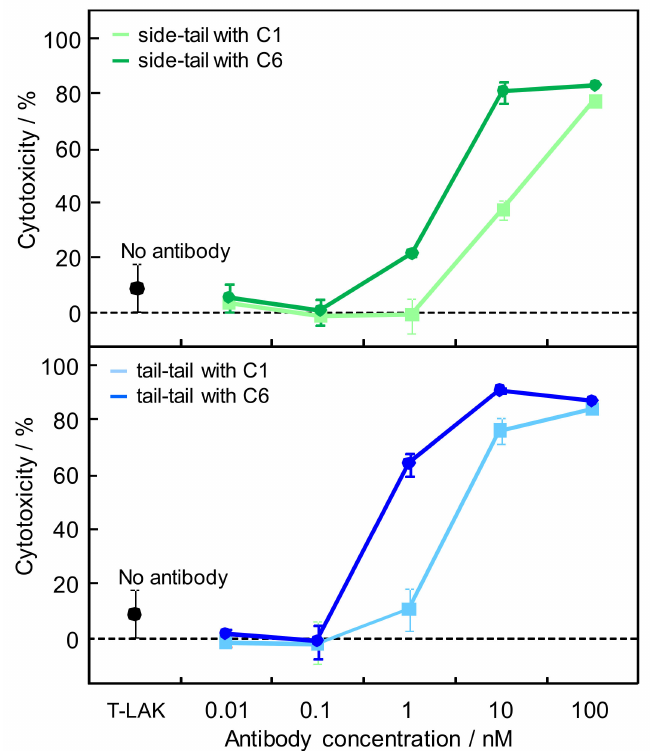
Figure 9. MTS assay of side–tail chemEx3 dimer with C1 and C6 linker (light green squares and green circles, respectively), tail–tail chemEx3 dimer with C1 and C6 linker (light blue squares and blue circles, respectively) for T-LAK and TFK-1 cells. On the horizontal axis, T-LAK indicates experiments without chemEx3 dimer but with T-LAK cells. The data are shown as means of three experiments ±